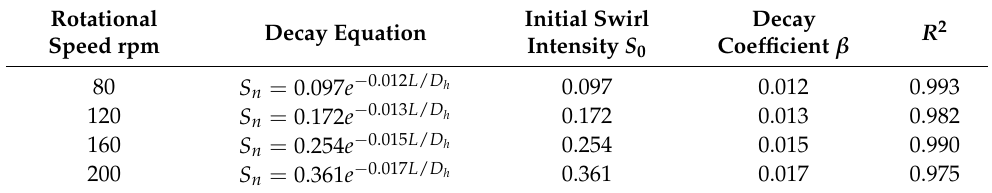
Figure 4. Decay law of swirl intensity of spiral flow induced by the hole cleaning device ( α = 0°) along the flow direction under different rotational speeds (numerical results). Table 3. Decay equation of spiral flow induced by the hole cleaning device ( α = 0°) under different rotational speeds (numerical results).